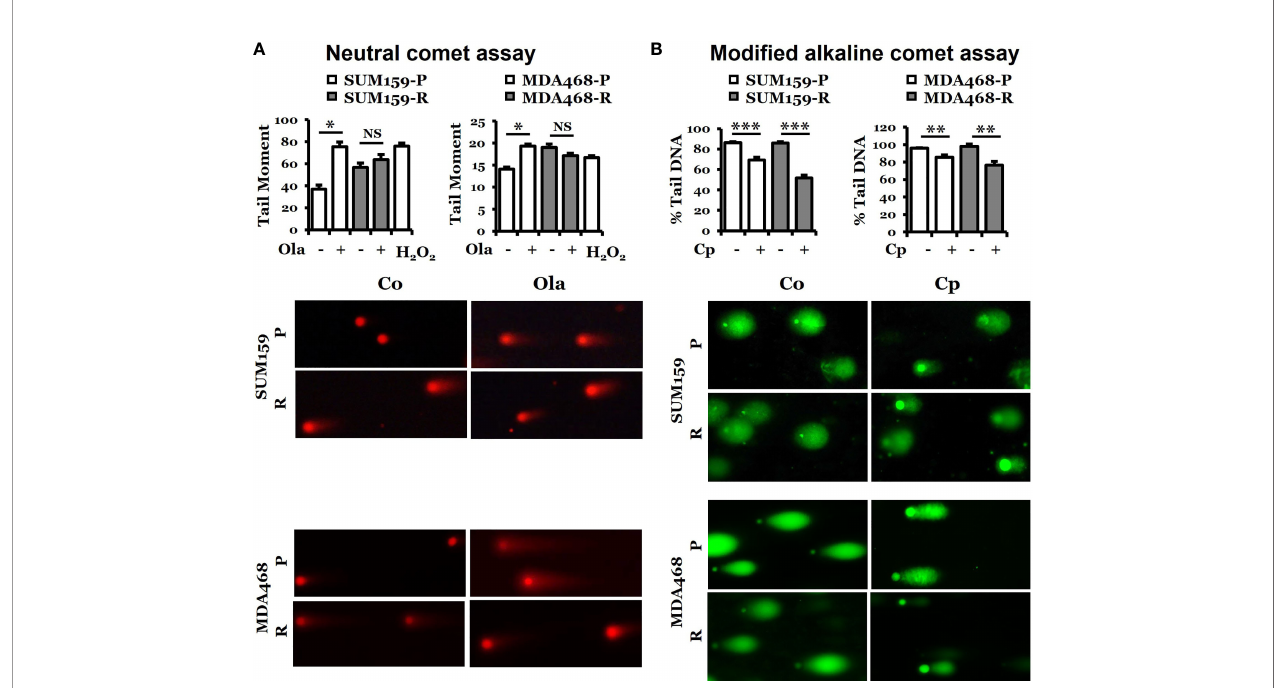
FIGURE 3 | Determination of DNA damage response in parental and olaparib resistant SUM159 and MDA468 cells by comet assays. (A) Neutral comet assay for detecting double-strand breaks in DNA in the form of tail moment. Parental and olaparib resistant SUM159 and MDA468 cells were treated with 15 µM and 10 µM olaparib for 24 hrs, respectively, followed by the electrophoresis of nuclear DNA. An average of 50 cells was used to calculate the tail moments. The lower panel shows a representative image of each group. (B) Modi fi ed alkaline comet assay for detecting DNA crosslinks in the form of percent tail DNA. Parental and olaparib resistant SUM159 and MDA468 cells were treated with 2 µM cisplatin for 24 hrs before the electrophoresis of nuclear DNA. An average of 50 cells was used to calculate the percent tail DNA. The lower panel shows a representative image from each group. Co, control; Ola, olaparib; Cp, cisplatin; P, parental; R, resistant and NS, not signi fi cant. Student ’ s t-test: * p < 0.05; ** p < 0.01 and *** p <